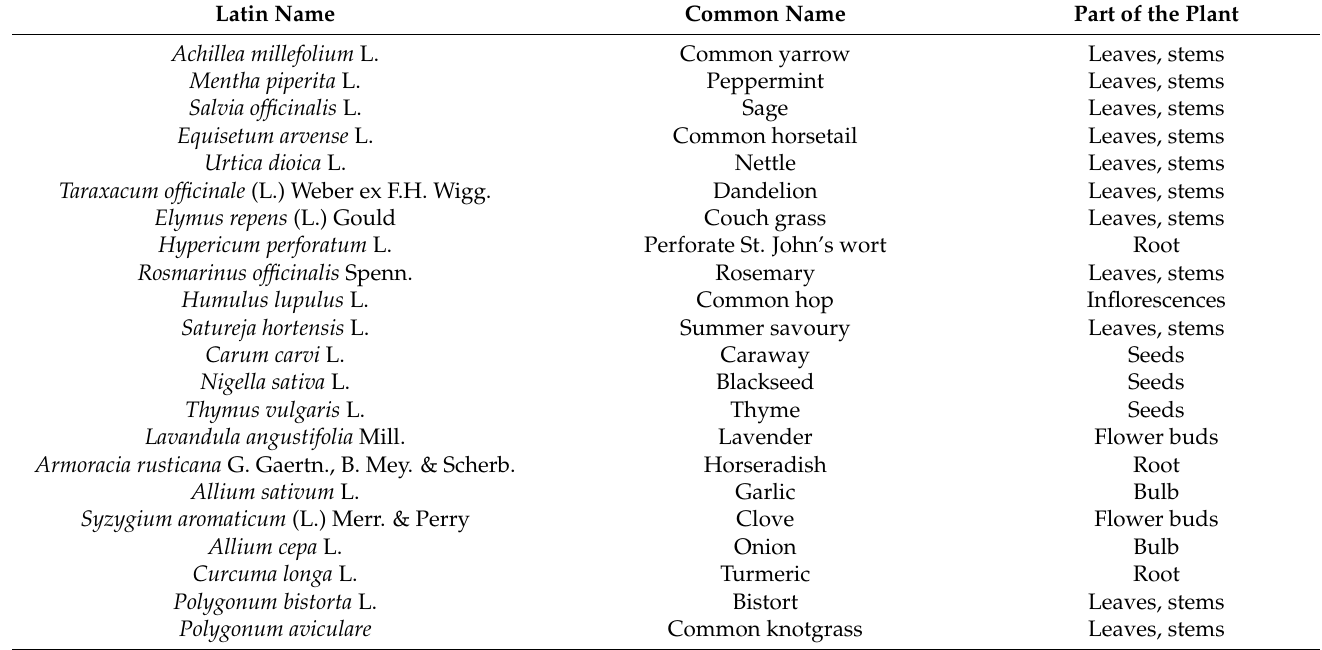
Table 7. Plant material used for the preparation of